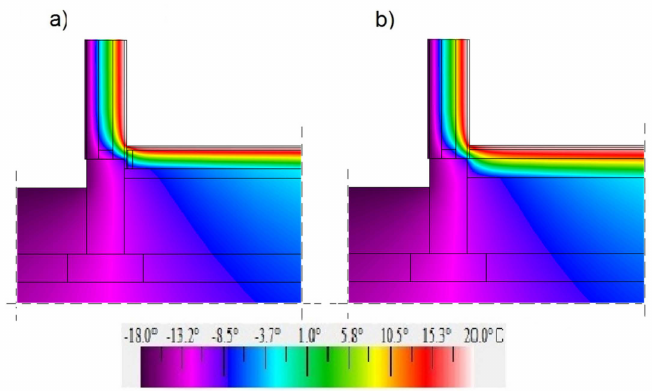
Figure 11. Temperature distribution in the ground junction with the “400c” wall filled with a hemp–lime composite ( λ = 0.080 W / (m · K)) and with the floor on the ground at the adopted level “0”: ( a ) floor on joists; ( b ) self-supporting floor.